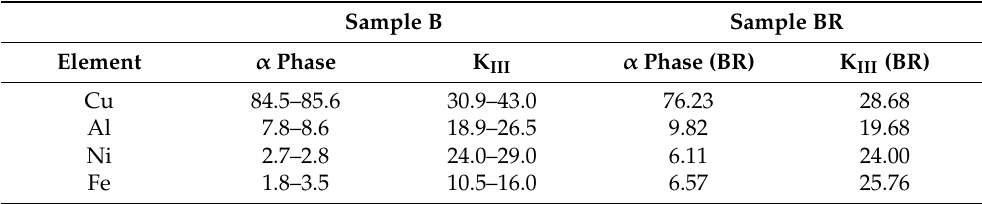
Table 3. Chemical composition of the phases for the B (as cast) and BR (annealed) samples (wt.%) obtained by EDX analysis. Sample B Sample BR Element α